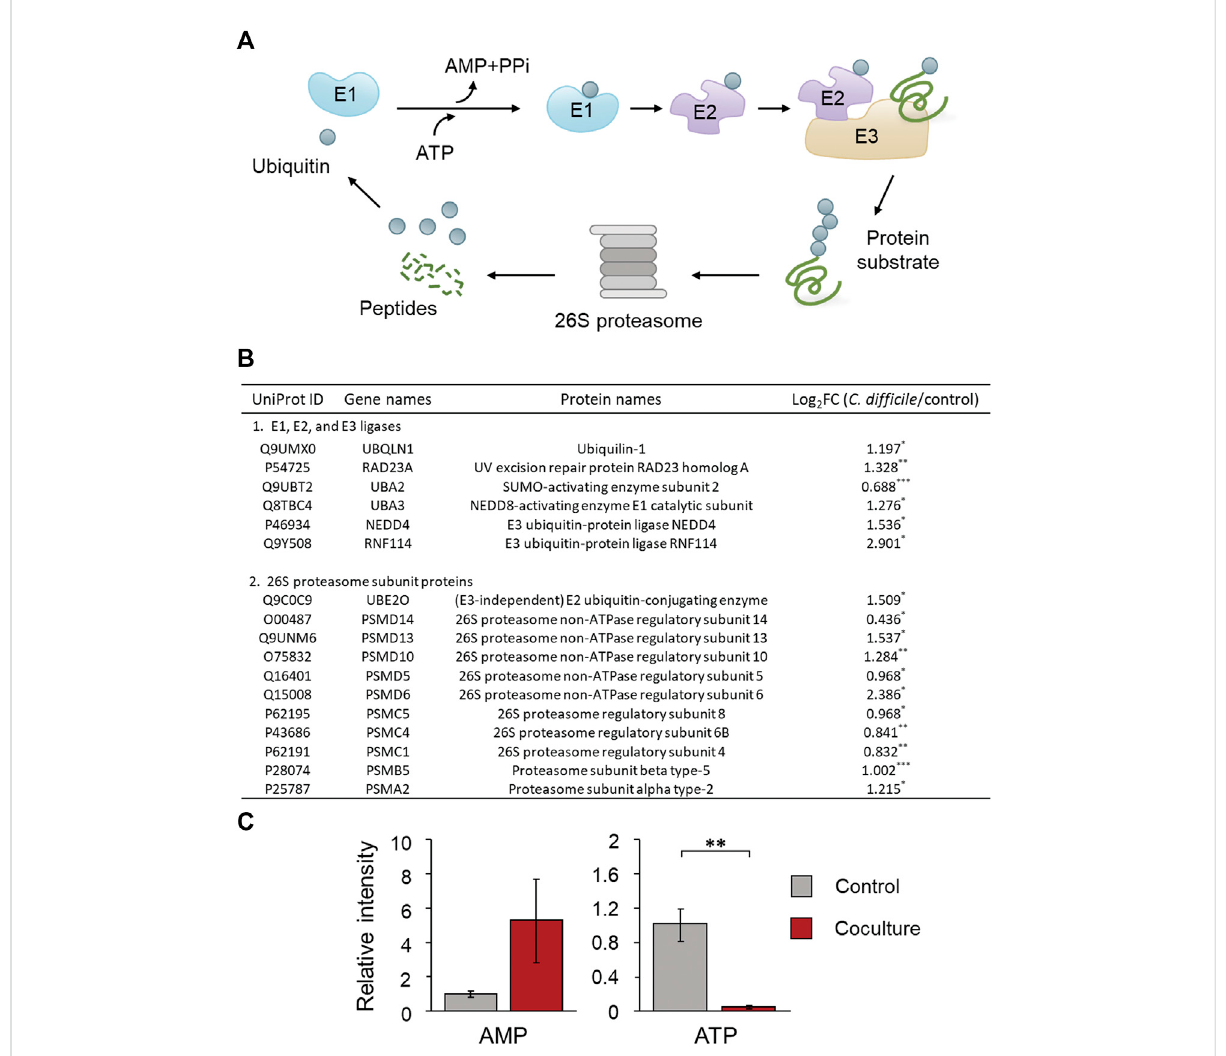
FIGURE 7 (A) Mechanism of the ubiquitin proteasome pathway (UPP) involved in proteolysis. Ubiquitin is conjugated to a protein substrate by three enzymes: E1, E2, and E3 ligases (Kocaturk and Gozuacik, 2018). This process is repeated until a chain of ubiquitin is formed. The ubiquitin chain is recognizedbythe26Sproteasome,andaftertheubiquitinisremoved,theproteinsubstrateisdigestedtopeptides. (B) Tableofproteinsbelongingto the UPP of Caco-2 cells cultured with C. dif fi cile . (C) Comparison of the production of AMP and ATP in Caco-2 cells cultured with C. dif fi cile . The error bars represent the standard deviation. Metabolomic analysis was performed in quadruplicate. Proteomic analysis was performed